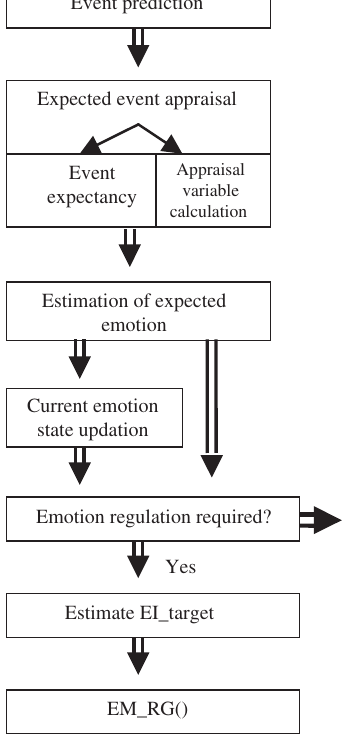
Figure 7. Flow Chart of Emotion Regulation